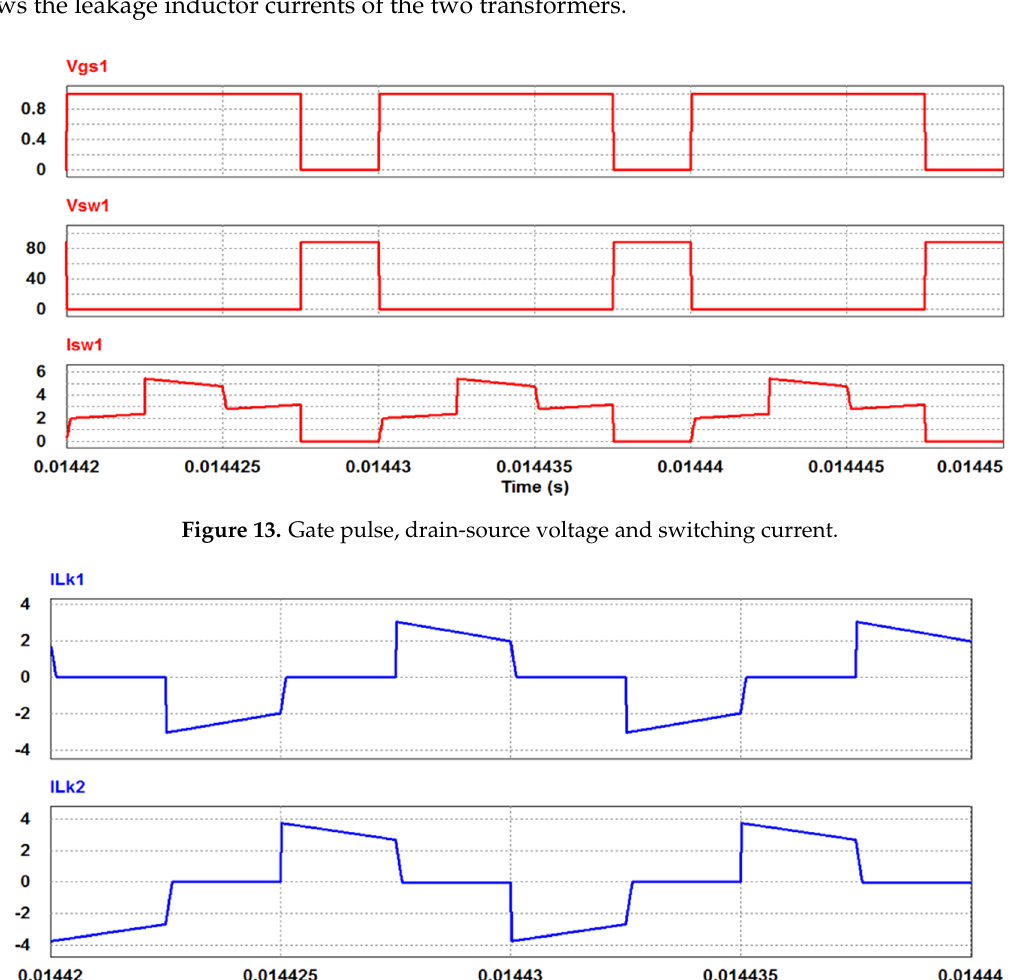
Figure 12. Inductor currents ( I Lin 3 , I Lin 4 ). Figure 13 depict switch parameters, namely switch pulse, switch voltage and switch current. The current through all four switches is obtained to be fairly equal indicating current sharing. Figure 14 shows the leakage inductor currents of the two transformers.